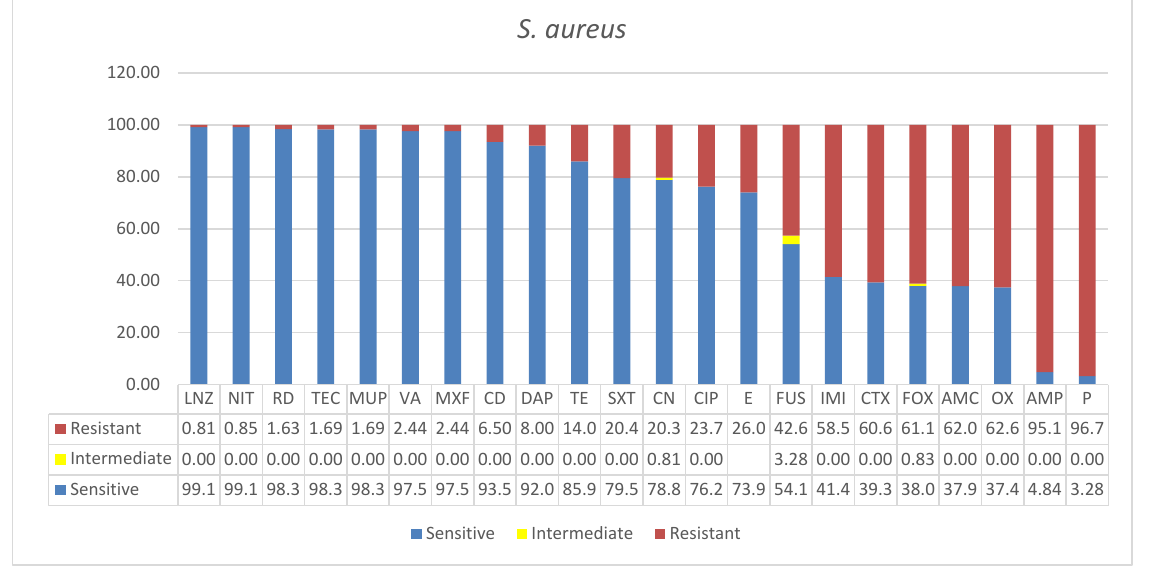
LNZ NIT RD TEC MUP VA MXF CD DAP TE SXT CN CIP